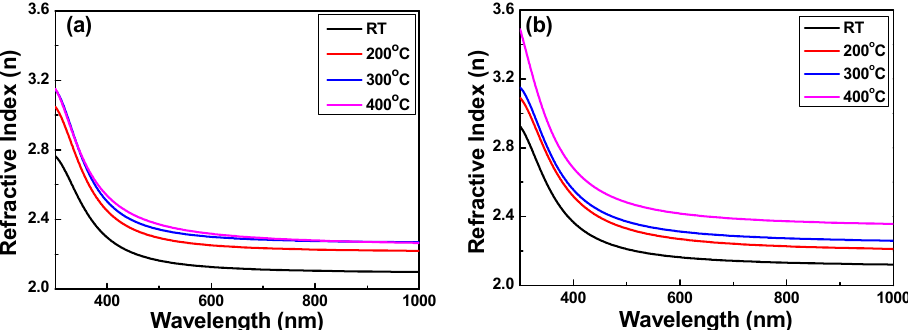
Figure 6. Measured refractive index of Nb 2 O 5 thin films as a function of deposition temperature and O 2 ratio. ( a ) O 2 ratio 10% and ( b ) O 2 ratio 20%, respectively.